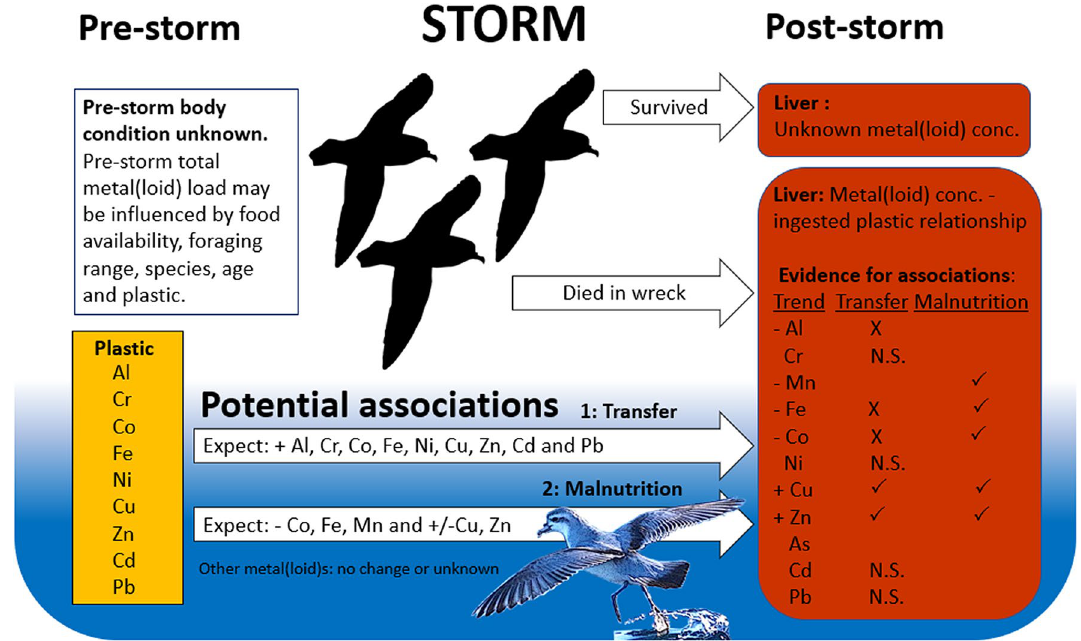
Figure 5. Response of liver concentration of metal(loid)s to ingested plastic in examined Pachytila seabirds; fairy prion (n = 25) and slender-billed prions (n = 25). Prions were collected dead in emaciated condition during a “seabird wreck”, following a significant off-shore winter storm in New Zealand, 2016, during which an estimated tens to hundreds of thousands of prions died. Statistical significance between metal(loid) concentration and plastic presence was tested by Mann–Whitney U-test. A positive sign ( +) indicates a significant positive relationship between ingested plastic and the liver concentration of each metal(loid), while a negative sign (-) indicates a significant negative relationship. Support for transfer and malnutrition associative mechanisms, predicted in the literature, is represented by a statistically significant relationship between ingested plastic and liver metal(loid) concentration. Observed relationship that match associations predicted in literature are represented by a tick ( ✓ ) and those that refute associations predicted in literature are represented by a cross (X). Not significant (N.S.) shows where a relationship was predicted, but no significant relationship was found. The results show partial support for transfer (2 ✓ , 3X) and support for malnutrition (5 ✓ , 0X). Prion silhouette and image manipulation created using GIMP 88